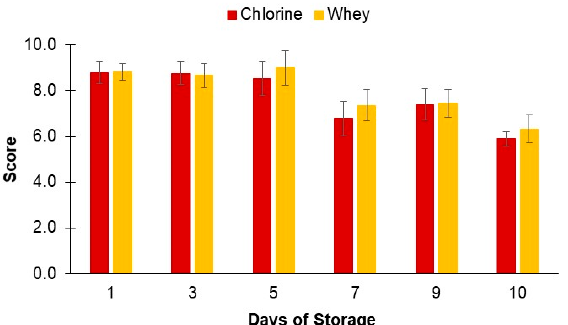
Figure 6. Overall acceptability of the lettuce treated with fermented whey and chlorine over 10 days in cold storage. Results represent the average of at least three replicate experiments (n = 3) ± SD.